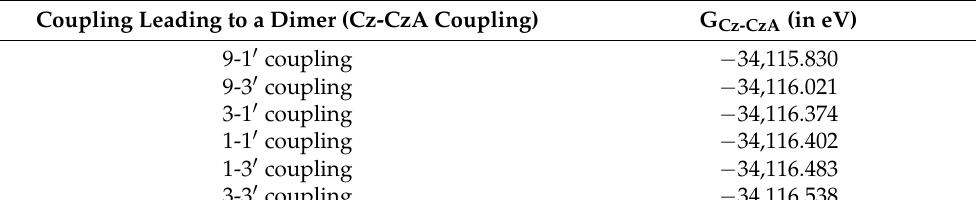
Table 1. Total free energy in solvent (in eV) of the different dimers that can be formed by coupling between Cz and CzA monomers. Calculations performed using the B3LYP DFT method with the 6-31G* basis set and the PCM model that includes solvent effects.